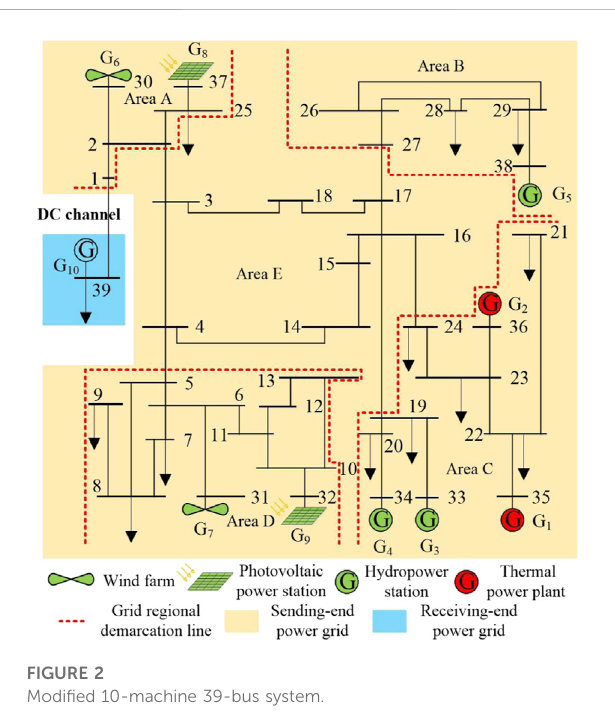
FIGURE 2 Modi fi ed 10-machine 39-bus